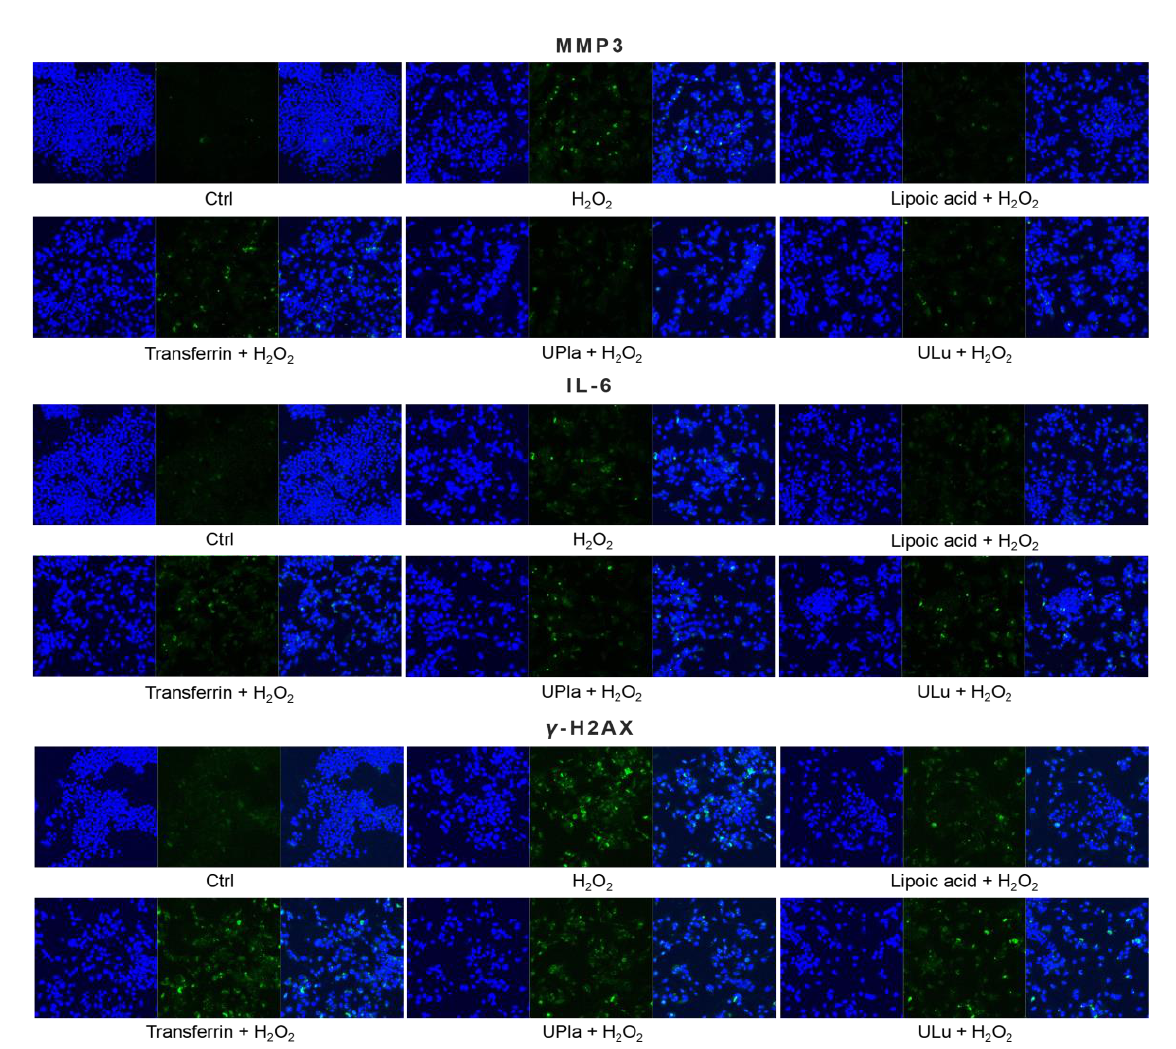
Figure 9. The expression of senescence markers was measured by immunofluorescence staining in HepG2 cells upon treatment with H 2 O 2 , with or without single substances. Cells were incubated with different senescence marker antibodies and counterstained by DAPI. The results represent similar results of three independent experiments.